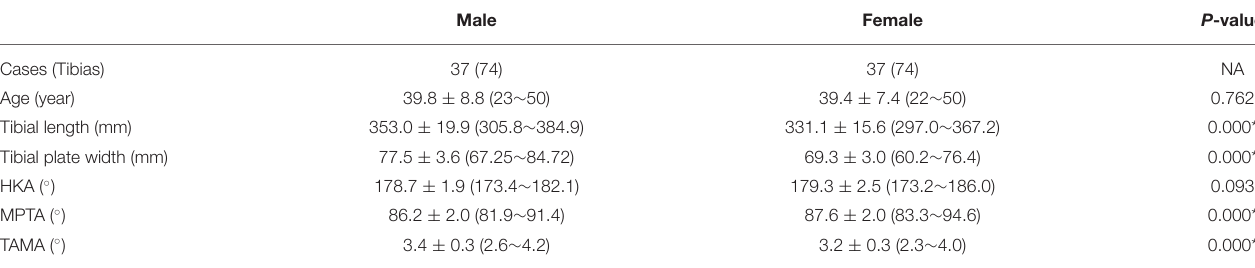
TABLE 1 | Demographic data and measurement of non-arthritic Tibia.